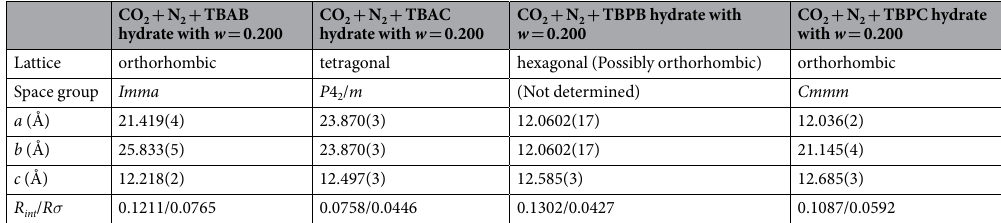
Table 1. Crystallographic data and structural refinement parameters for the single crystals of ionic clathrate hydrate formed in this study.